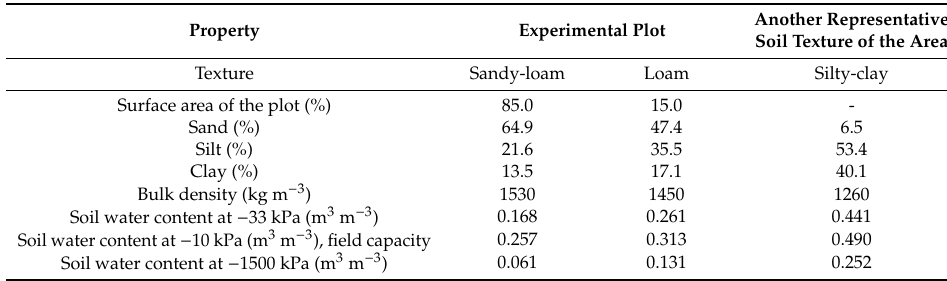
Table 1. Main physical characteristics of the soil at the upper 25 cm in the experimental plot and in soil representative of the Baix Ter rice production area. Property Experimental Plot